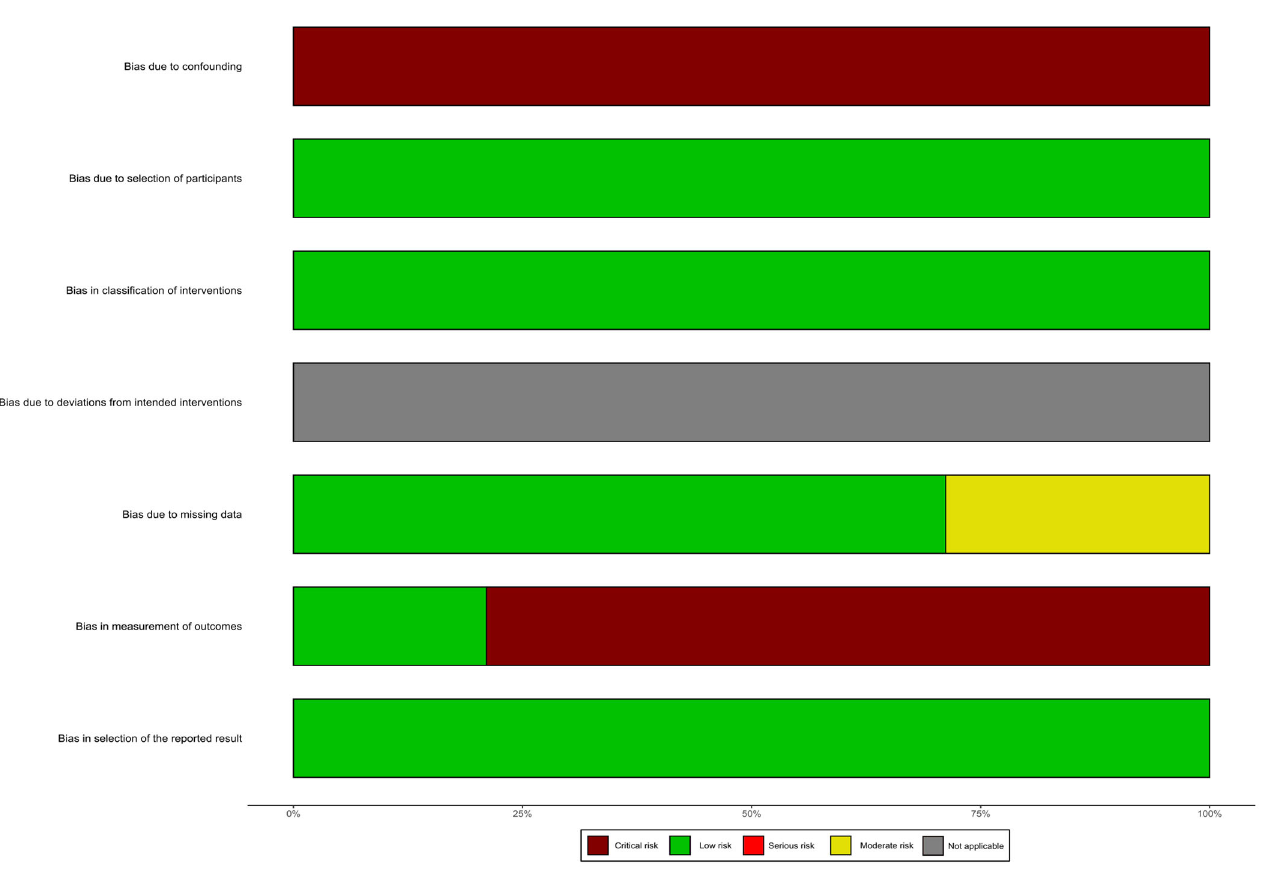
Figure 2. Risk of bias assessment according to the ROBINS-I guidelines (Risk of Bias in Non- randomized Studies of Interventions).